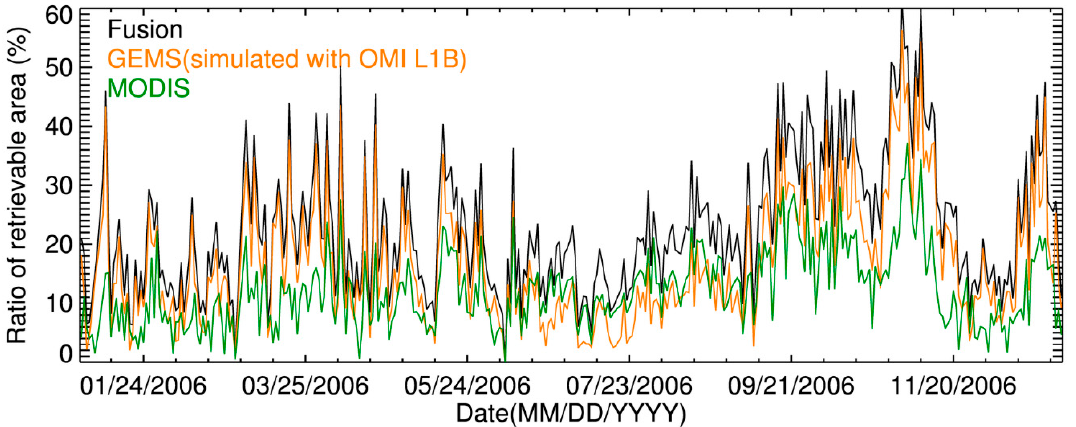
Figure 11. Ratio of retrieved area for fused AOD dataset and source AOD products for 1 January to 31 December 2006.